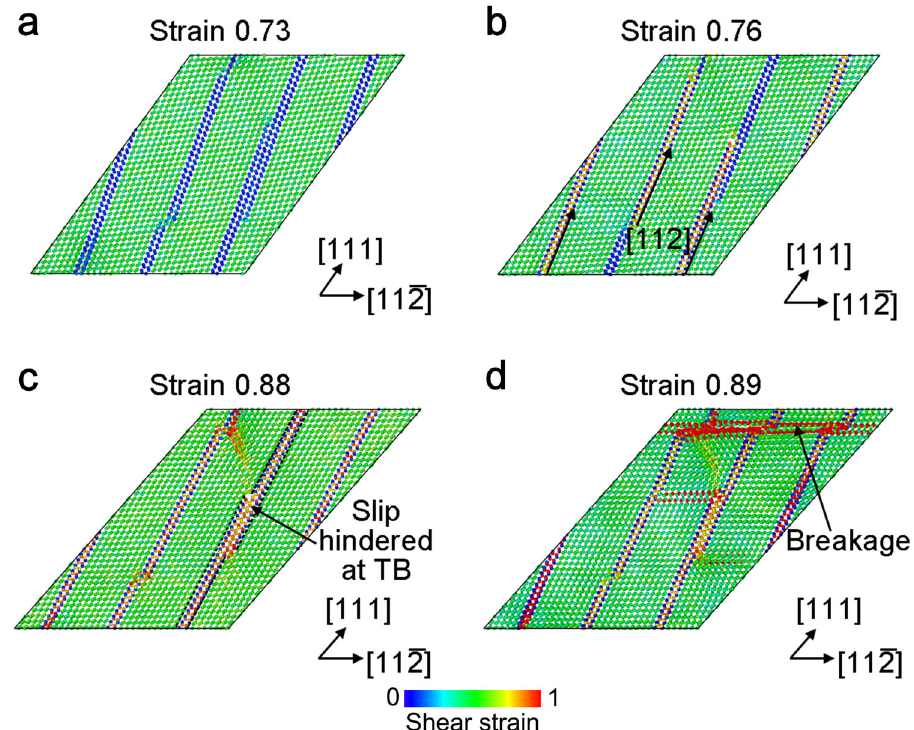
Fig. 4 Structural deformation during the strengthening and failure stage. a – d Deformation of whole structure at strain a 0.73, b 0.76, c 0.88, and d 0.89. Atoms are color coded by the atomic shear strain. In b , there are slips along the ð 111 Þ½ 112 (cid:2) direction in the matrix. In c , the slips along the ð 111 Þ½ 112 (cid:2) direction are hindered by TBs. In d , the breakage along ð 111 Þ½ 112 (cid:2) direction initiates at TBs, leading to the structural